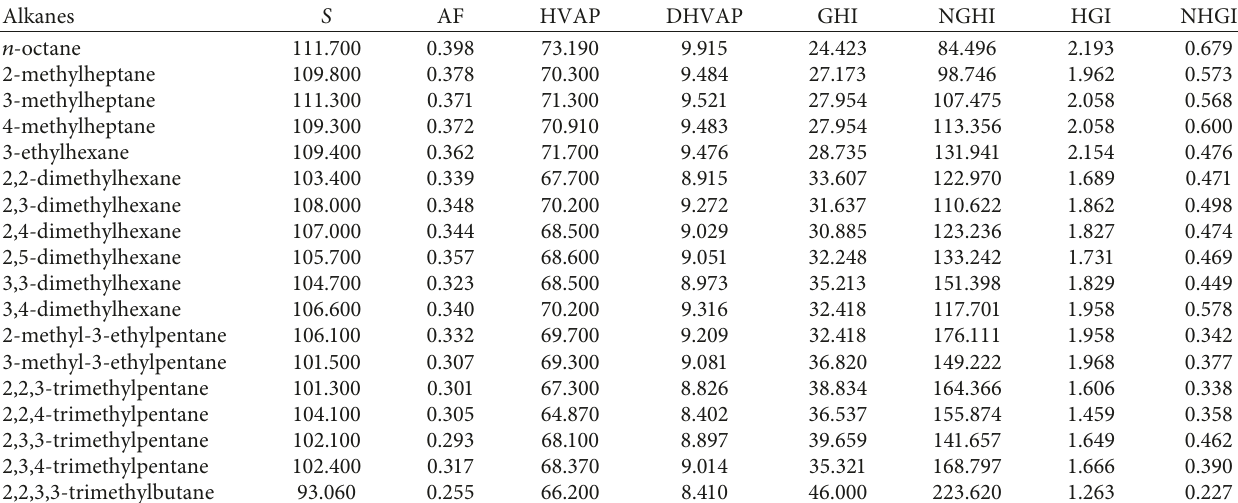
Figure 1: All octane isomers (each carbon item is considered a vertex and a bond between carbon atoms is treated as edges, whereas hydrogen atoms are ignored because of structural similarities). Table 1: Octane isomers and experimental values of S , AF, HVAP, and DHVAP along with corresponding values of the GHI, NGHI, HGI, and